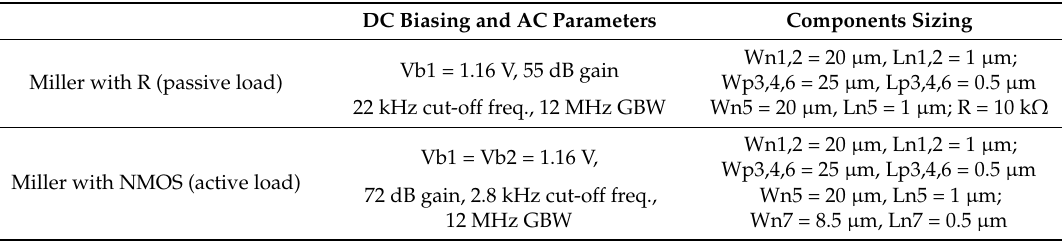
Figure 16. Schematic ofthe Miller amplifier: ( A ) with active load, ( B ) with resistive load. Table 4. DC and AC parameters and Transistor Sizing of the Two Stages